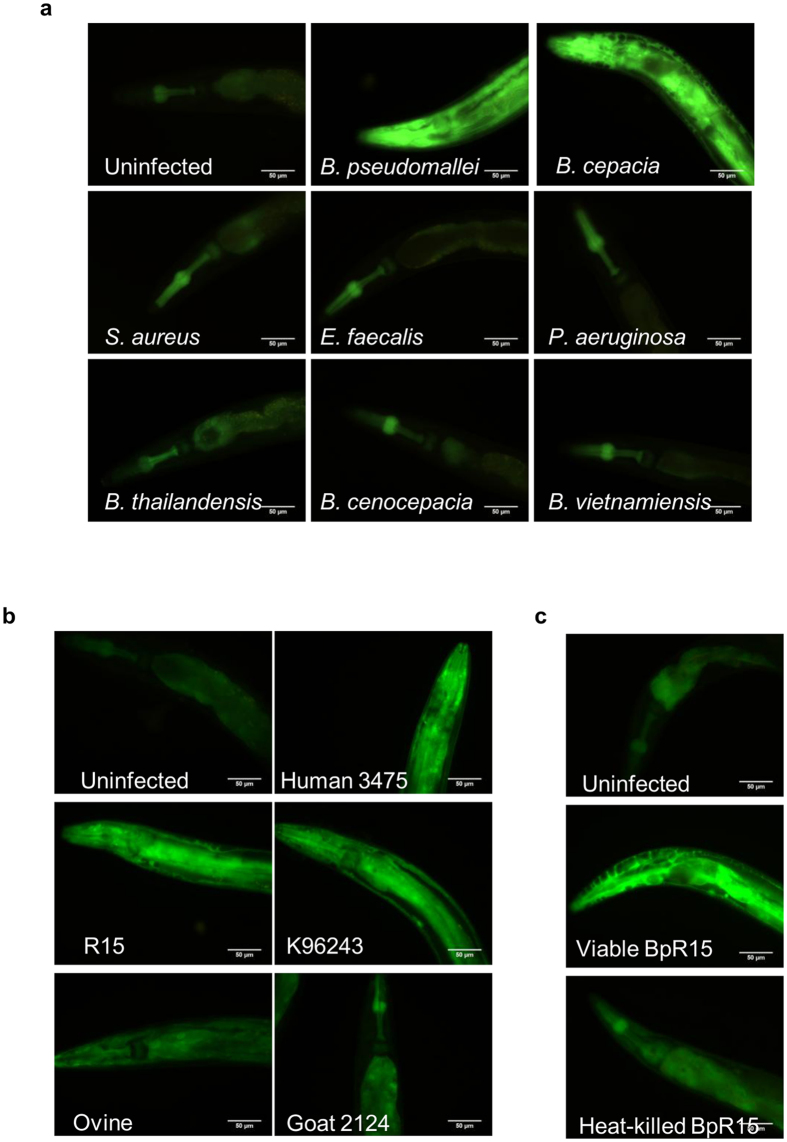
Strong ugt-29 expression is specific to infections by virulent Burkholderia species and strains.Representative fluorescence micrographs (400× magnification) of ugt–29::GFP reporter worms exposed to (a) various pathogens at 24 hours post infection, (b) individual B. pseudomallei isolates at 8 hours post infection and (c) heat-killed BpR15 relative to viable BpR15 at 24 hours post infection. All micrographs were acquired at same exposure time and gain factor. Scale bar, 50 μm.